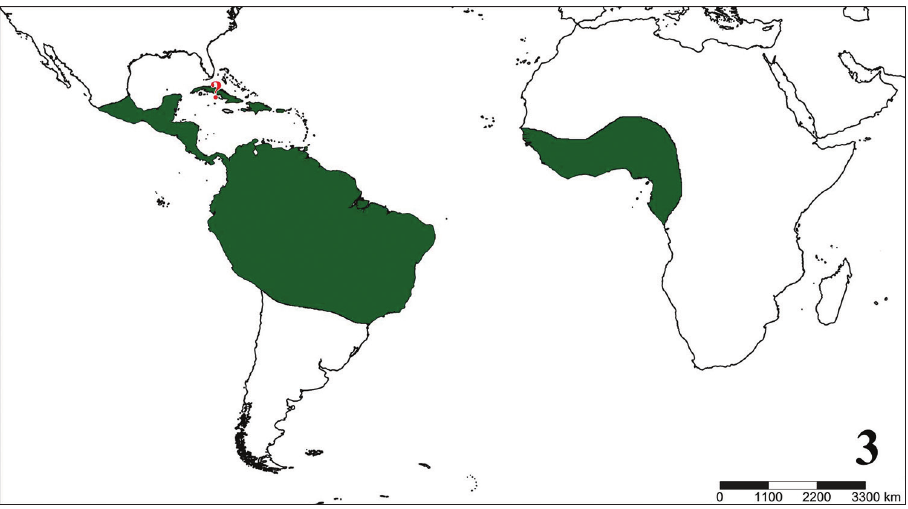
Figure 3. Approximate distribution area of Aviculariinae. ? = dubious